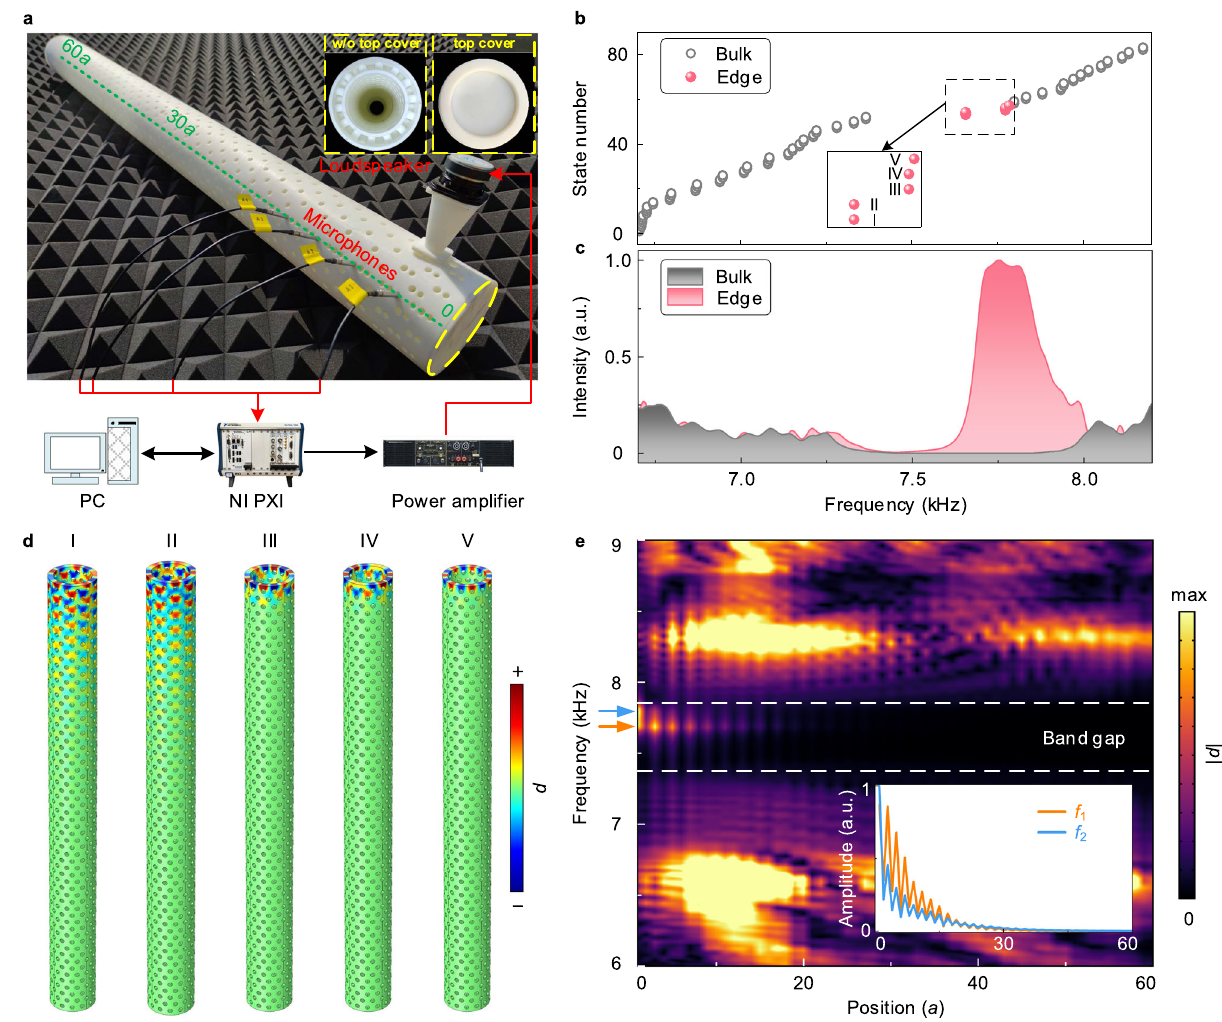
Fig.3|Topologicaledgestates.a PhotographofthefabricatedAGT.Insets:ori fi ce withoutandwiththetopcover. b Calculatedeigenfrequenciesofthe fi nite(1,0)14- AGT. Gray circles and red dots represent the bulk and topological edge states, respectively. c Measuredsoundintensityspectraforthosestates. d Corresponding